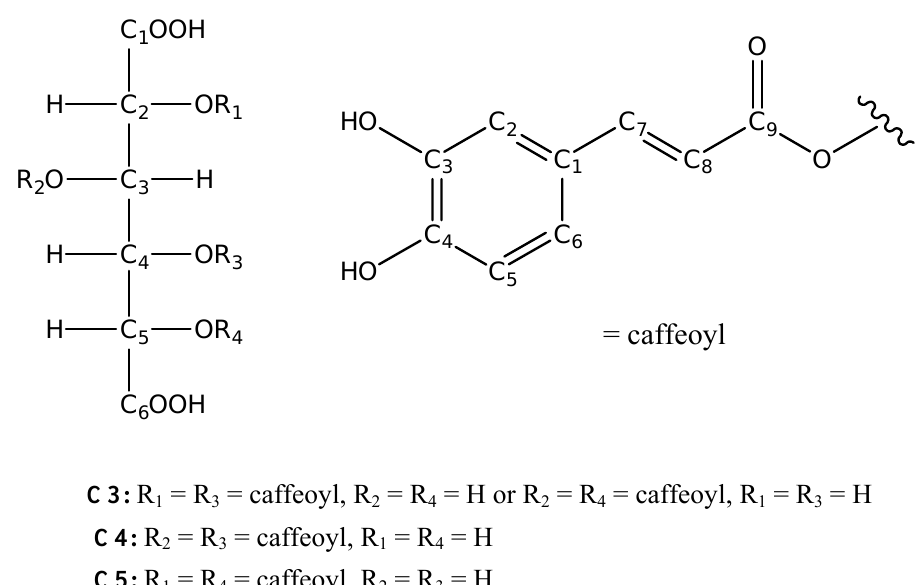
Figure 2. Structure of dicaffeoylglucaric acid derivatives C3 , C4 and C5 from E. perfoliatum